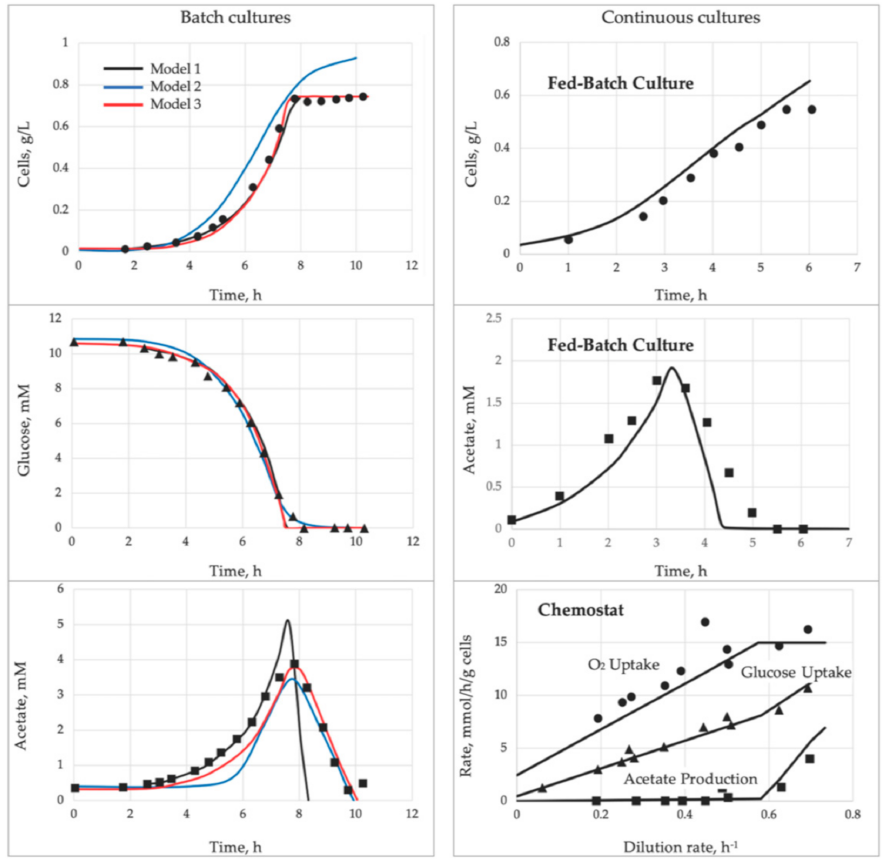
Figure 7. Dynamic FBA simulation of E. coli grown in a simple batch culture ( left column ) and in con- tinuous systems ( right column ). The experimental data [86,87] were fitted to the following dynamic FBA models: Model 1 , the SOA computational approach [87]; Model 2 , the DOA approach [105]; and Model 3 , the integrated hybrid FBA/ODE simulation with added transcriptional control [94]. Reprinted with permission from [87], copyright (1994) American Society for Microbiology and with permission from [59], copyright (2019)